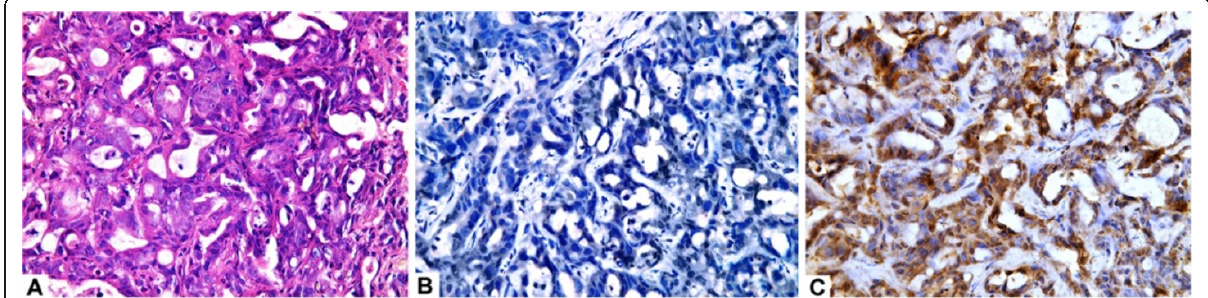
Figure 5 A case of cholangiocarcinoma (A; H&E,original magnification x400) with negative arginase-1 immunostaining (B;immuoperoxidase, original magnification,x400), stong and diffuse staining with HepPar-1 (C; immuoperoxidase, original magnification,